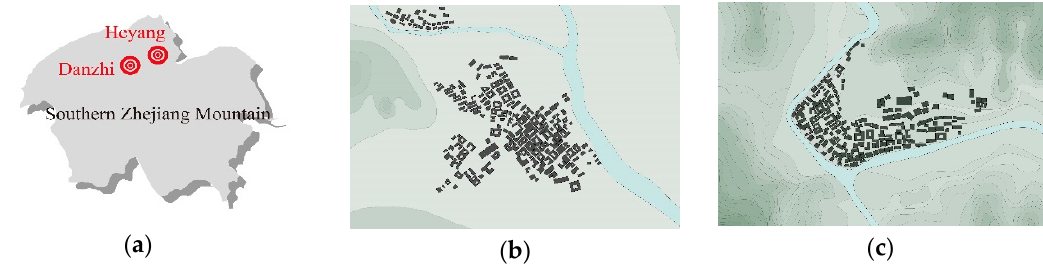
Figure 1. ( a ) Location of sample villages and the layouts of ( b ) Heyang and ( c ) Danzhi.